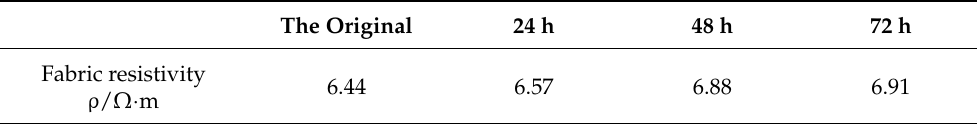
Table 1. The resistivity of rGO fabrics in air with different test times.